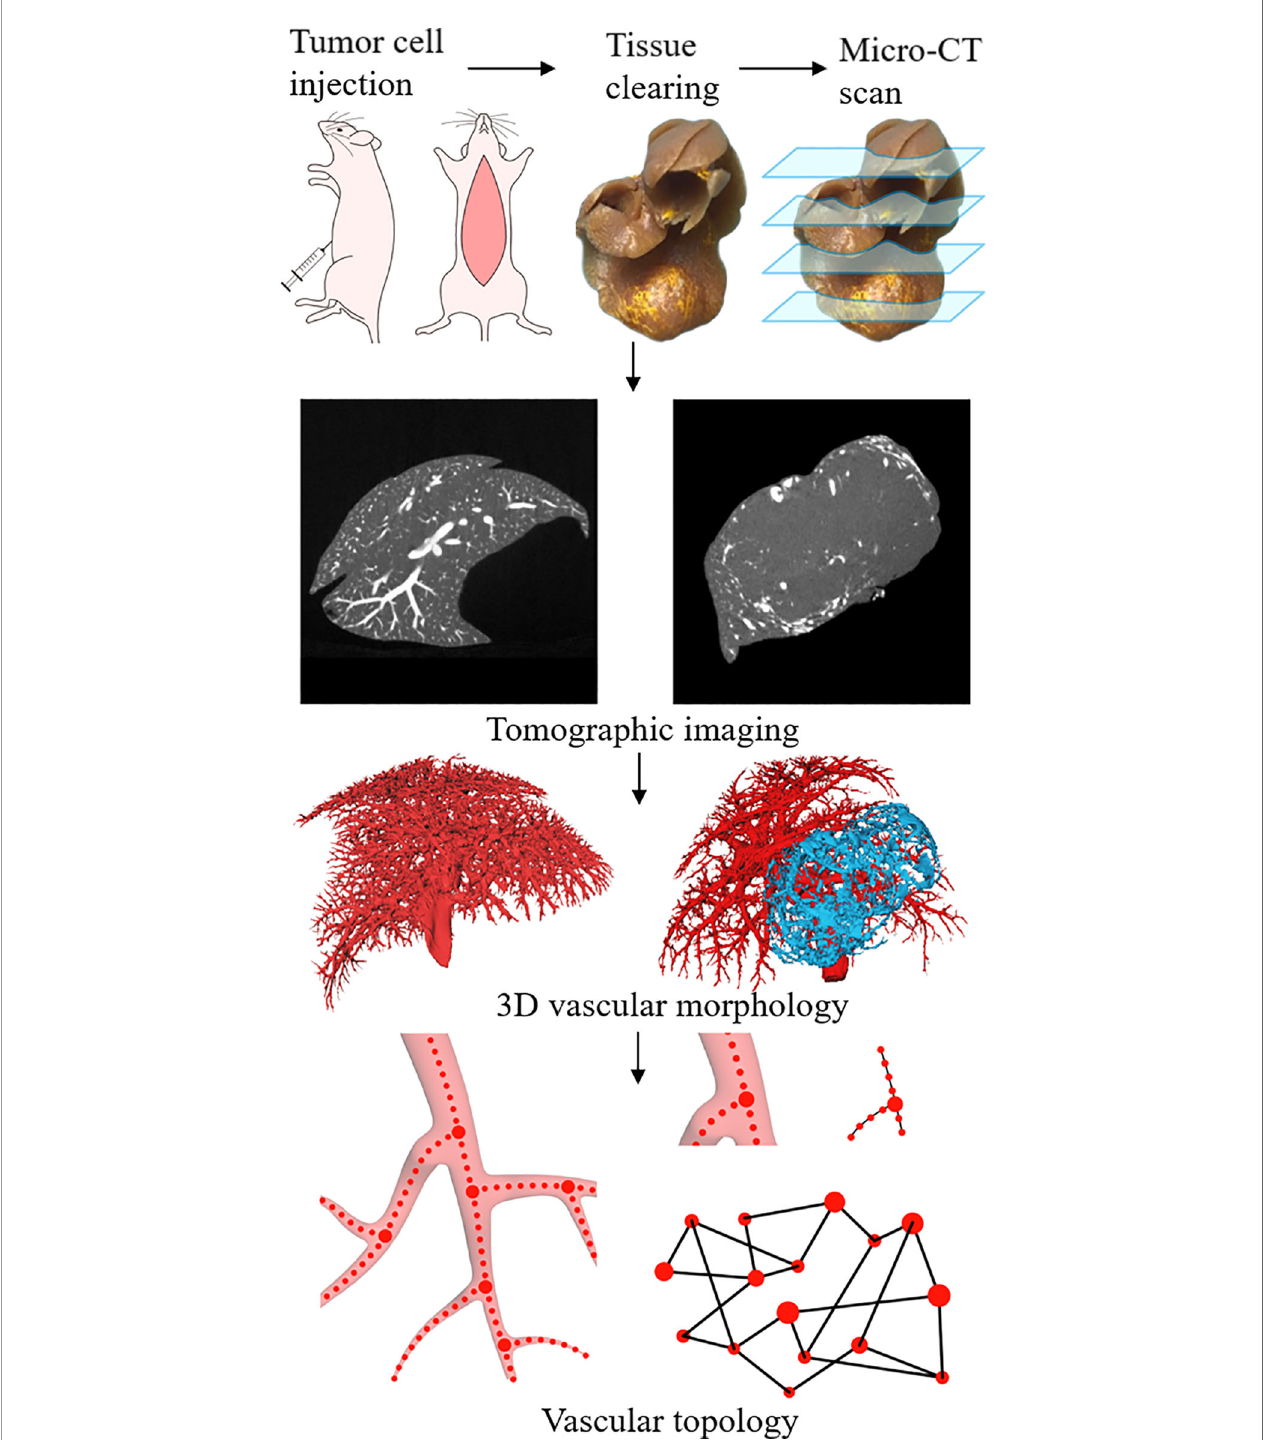
FIGURE 1 | Schematic illustration of experimental procedures, including tumor cell injections, tissue perfusion and clearing, and Micro-CT scan. Extraction of vascular network based on the 3D structure reconstructed from tomographic images. Using the vascular skeleton, the network topology is studied.